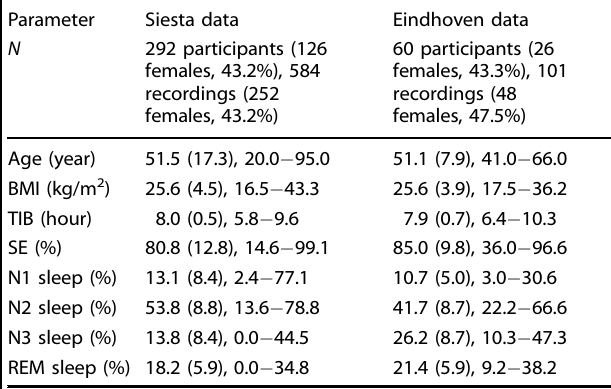
Fig. 3 Overview of the validation scheme. The top horizontal lane describes operations done using the Siesta data while the bottom lane describes the validations on the Eindhoven data. Square boxes describe model training operations, rounded black boxes describe endpoints that are statistically compared to con fi rm the hypothesis of this work, and the rounded grey box denotes the trained ECG model, which is used either as a pre-trained model or adapted via knowledge transfer for PPG-based sleep stage classi fi cation as indicated by the arrows fl owing out of it. CV means cross-validation across participants. Table 1. Demographics and sleep statistics of participants in the two data sets used in the